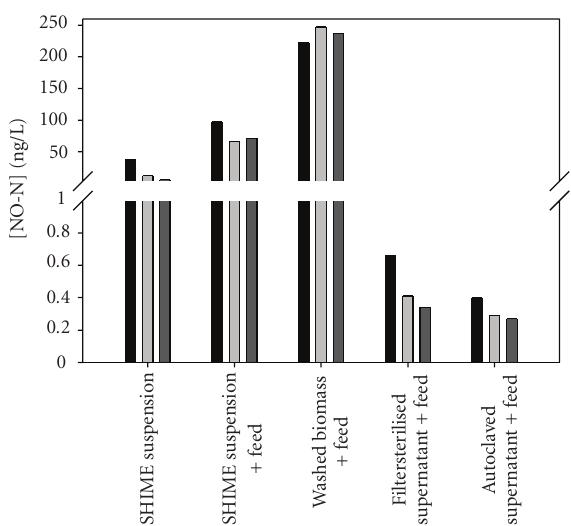
Figure 4: NO-N concentrations produced by the microbiota of the 3 colon vessels (black = colon ascendens (CA), light grey = colon transversum (CT), dark grey = colon descendens CD)) of the in vitro SHIME model measured in the headspace. The microbial suspension of the 3 vessels was incubated anaerobically for 24 hours with or without fresh feed medium or washed and resuspended in fresh feed medium. The supernatant of the SHIME suspension was incubated as well in the feed medium after filtersterilisation or